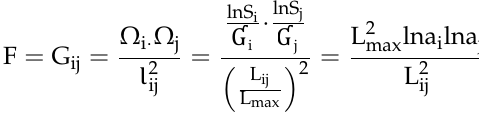
Figure 5. Cost path formation.